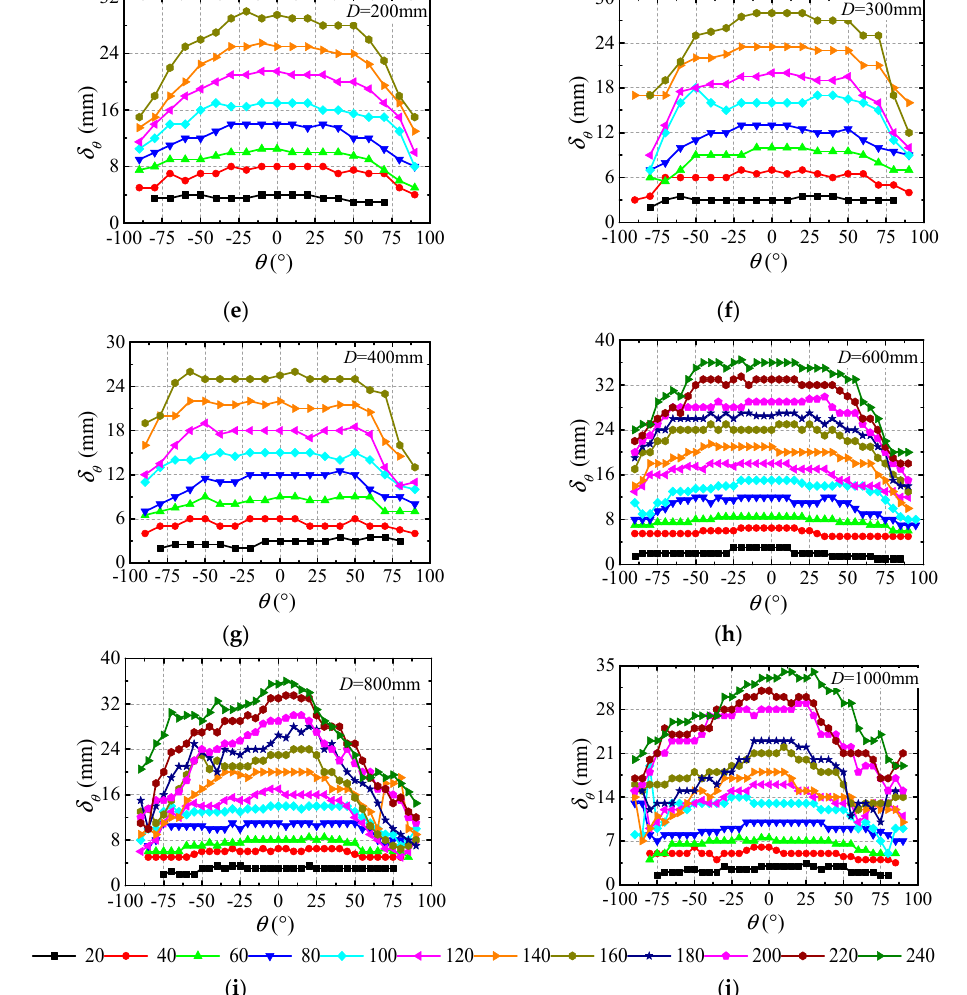
Figure 12 . Thickness of radial ice at various N : ( a ) D = 25 mm, ( b ) D = 50 mm, ( c ) D = 100 mm, ( d ) D = 150 mm, ( e ) D = 200 mm, ( f ) D = 300 mm, ( g ) D = 400 mm, ( h ) D = 600 mm, ( i ) D = 800 mm, and ( j ) D = 1000 mm.